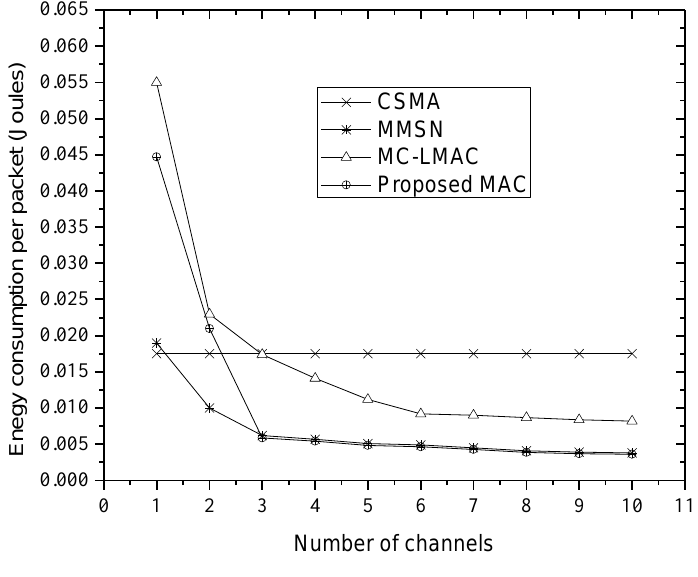
Figure 6. Energy consumption per successfully delivered packet with different numbers of